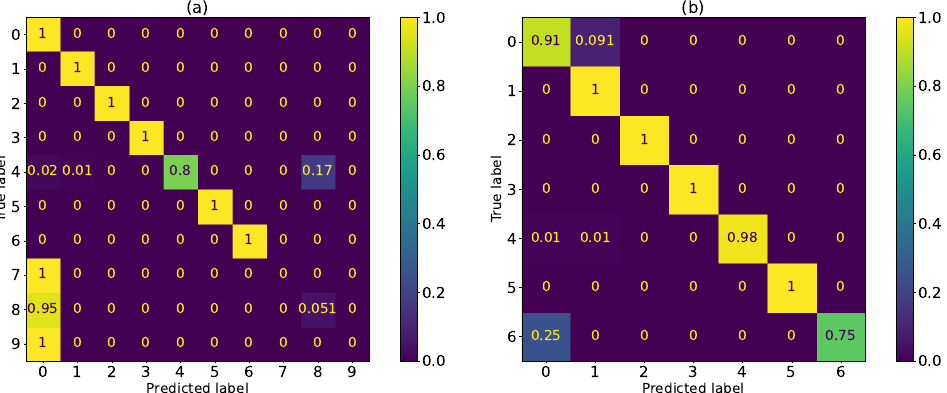
Figure 11. Confusion matrix with results of accuracy for each fault case for the validation data ( a ) and validation data without bearing faults (training data also without bearing faults) ( b ). 0: Healthy state; 1: undervoltage; 2: unsymmetrical voltage; 3: open phase; 4: broken bar; 5: winding short circuit; 6: mixed eccentricity; 7: bearing—outer ring fault; 8: bearing—inner ring fault; 9: bearing—global